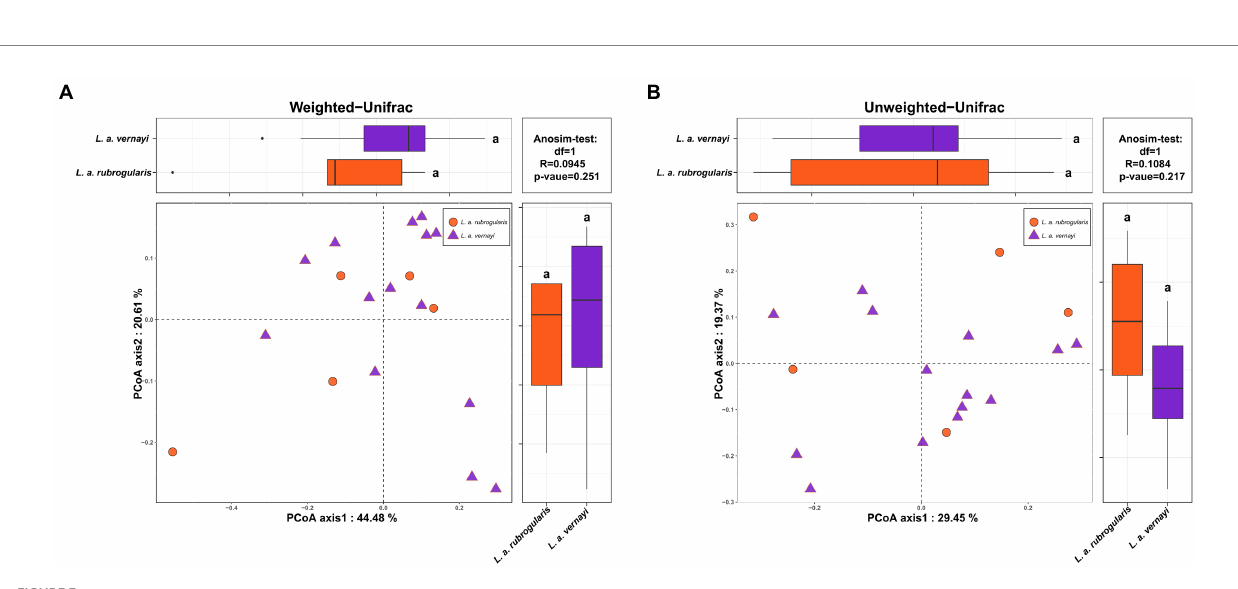
FIGURE 3 Beta diversity of gut microbiota in the L. a. rubrogularis and L. a. vernayi . (A) Principal coordinates analysis (PCoA) based on weighted UniFrac distance (B) and unweighted UniFrac distance. Wilcoxon rank-sum test of two subspecies on the first axis is shown on the upper left; Wilcoxon rank-sum test of two subspecies on the second axis is at the lower right; Anosim-test results based on bray-Curits distance between two subspecies are shown in the upper